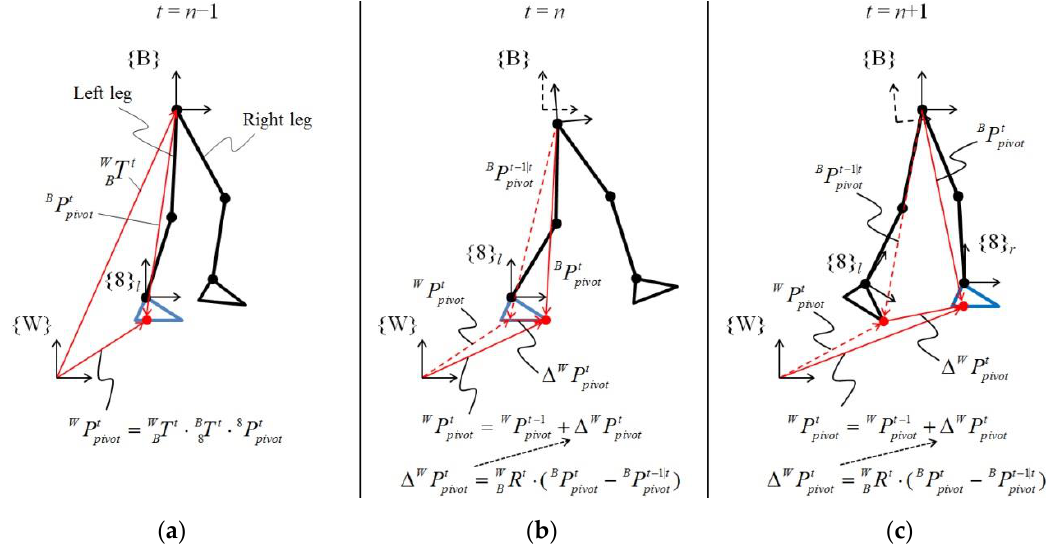
Figure 16. Calculation of the pivot vector on frame {W} according to the contact phase of feet. ( a ) At the first contact of a foot with the ground, the CoP of the supporting leg is set to the pivot. ( b ) As the CoP moves during foot flat phase, the pivot is continuously updated for the variation of the CoP. ( c ) When the supporting leg is changed to the other leg, the position vector between both feet is used to update the pivot.